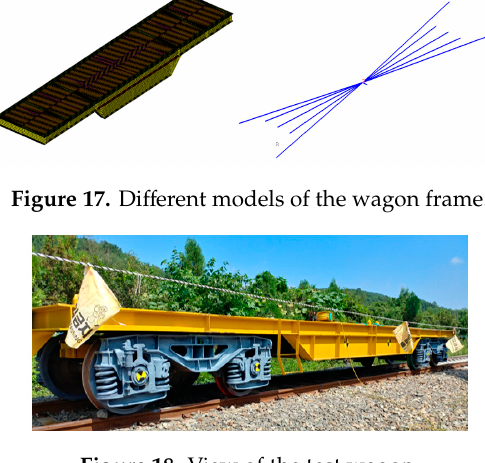
Figure 17. Different models of the wagon frame. F igure 18. View of the test wagon.